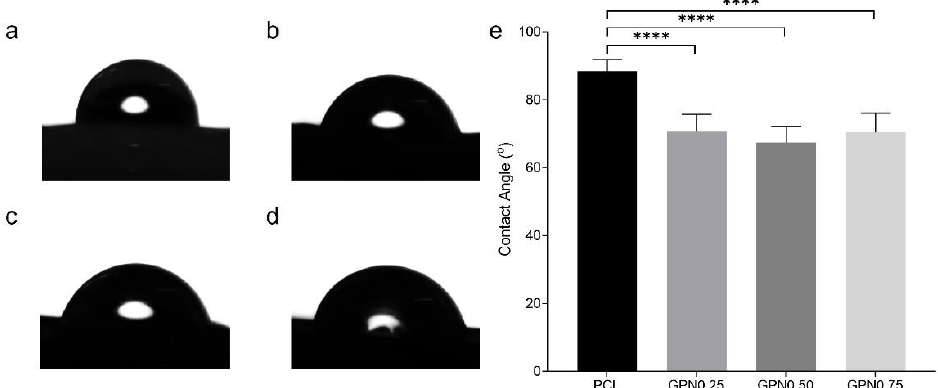
GPN0.50, and ( d ) GPN0.75. ( e ) Contact angle measurements of the scaffolds. Statistical